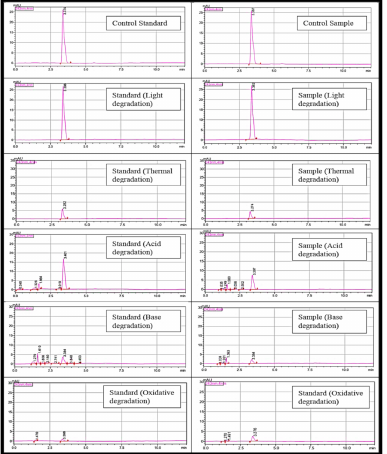
Figure 2. Chromatograms of standard and sample at control and after forced